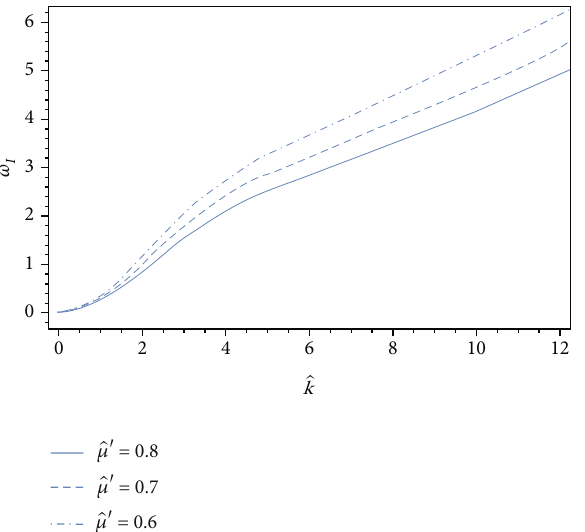
Figure 10: E ff ect of viscoelastic ratio of fl uids on growth rate at b ρ = 0 : 002 , Oh = 100 , b μ = 0 : 4 , L = 0 : 3 , b β = 0 : 6 , b ε = 6 , and ̂ H = 20 . e 1